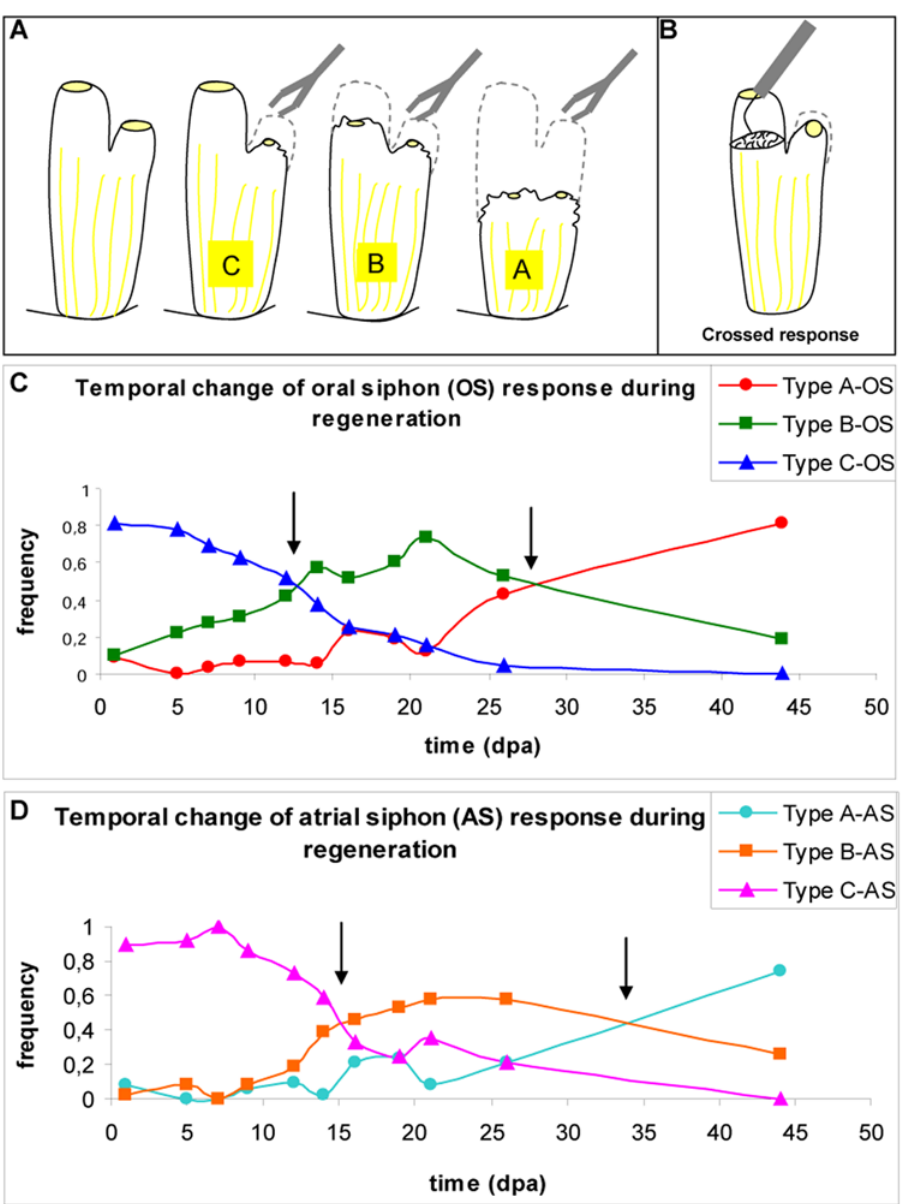
Figure 3. Functional regeneration assessed with the siphon stimulation test (SST). A Reflexes described in this paper in response to SST: type A, type B and type C. B Tentacle stimulation test (TST). Recovery of the reflex response of oral ( C ) and atrial ( D ) siphons. Frequency of each reflex response over time. The non ablated reflex response is characterized by , 80% type A and 20% type B reflexes. Arrows indicate the transitions from type C– . B and type B– .